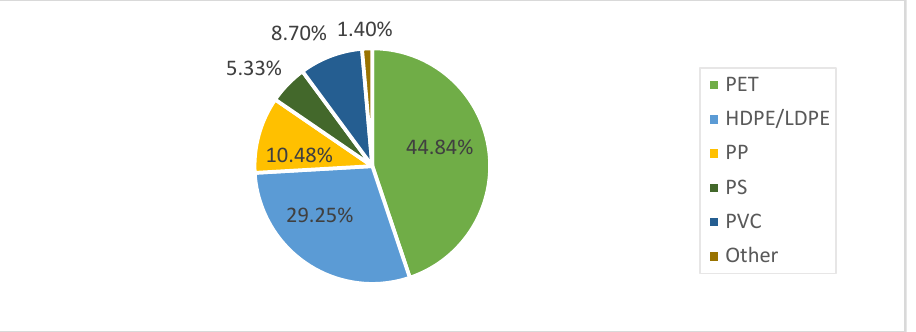
Figure 1. Distribution of primary plastic waste in Ecuador. Adapted from [4].